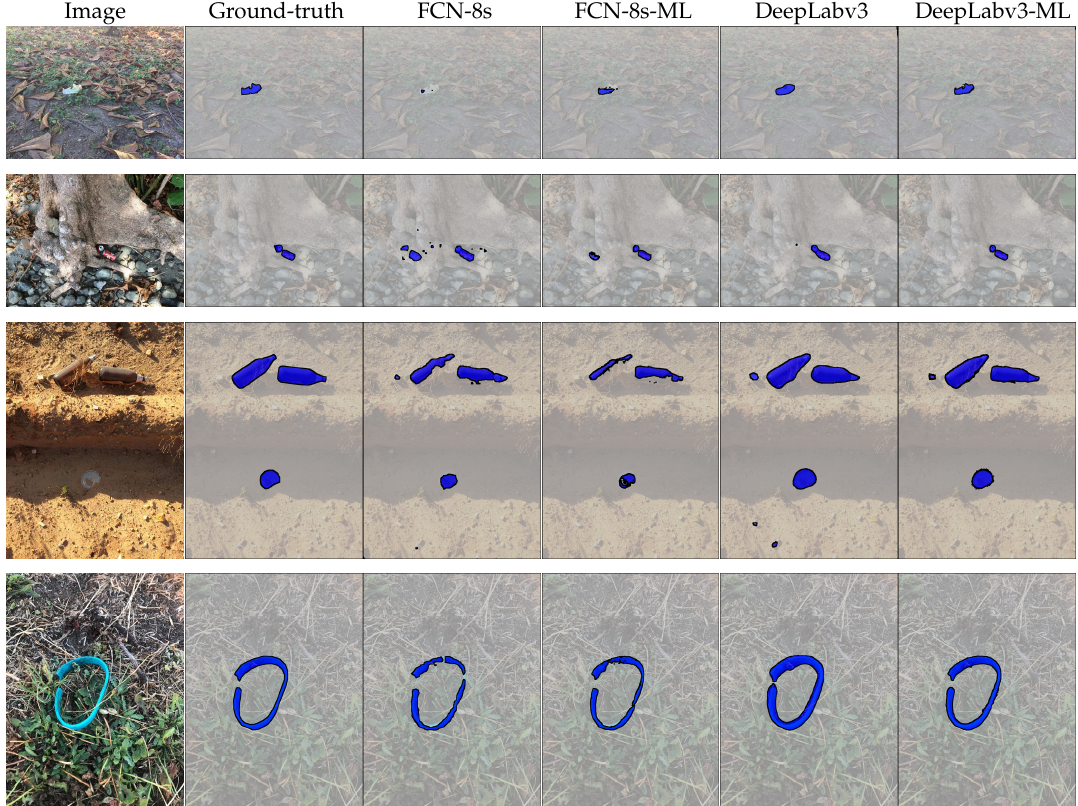
Figure 8. Example segmentation results on the TACO test set. Input images and ground-truth annotations are shown in the first two columns. Baseline methods are FCN-8s (VGG-16) and DeepLabv3 (ResNet-101). Our proposed methods (FCN-8s-ML and DeepLabv3-ML) more accurately recover object boundaries. Best viewed electronically, zoomed